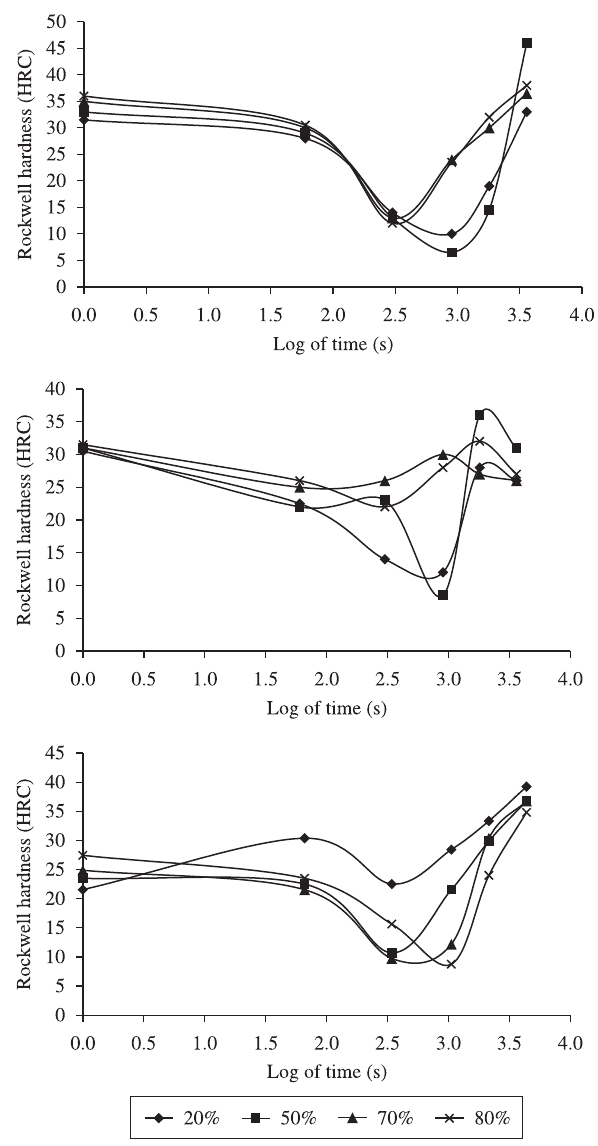
Figure 3. Rockwell hardeness vs. Annealing time plot for: a) 300 °C tempered martensite specimens treated at 760 °C; b) 500 °C tempered martensite specimens treated at 760 °C and c) 650 °C tempered martensite specimens treated at 760